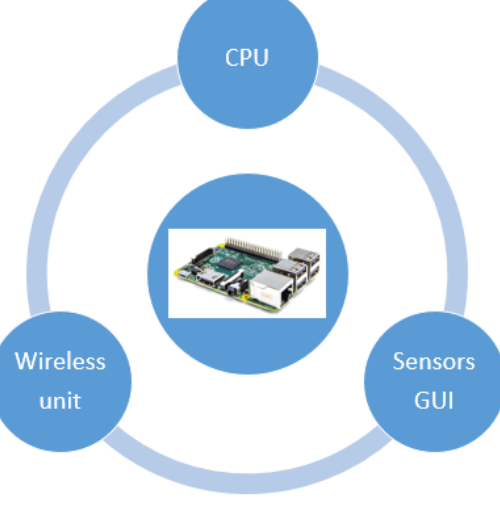
Figure 3. Monitor or sensing unit